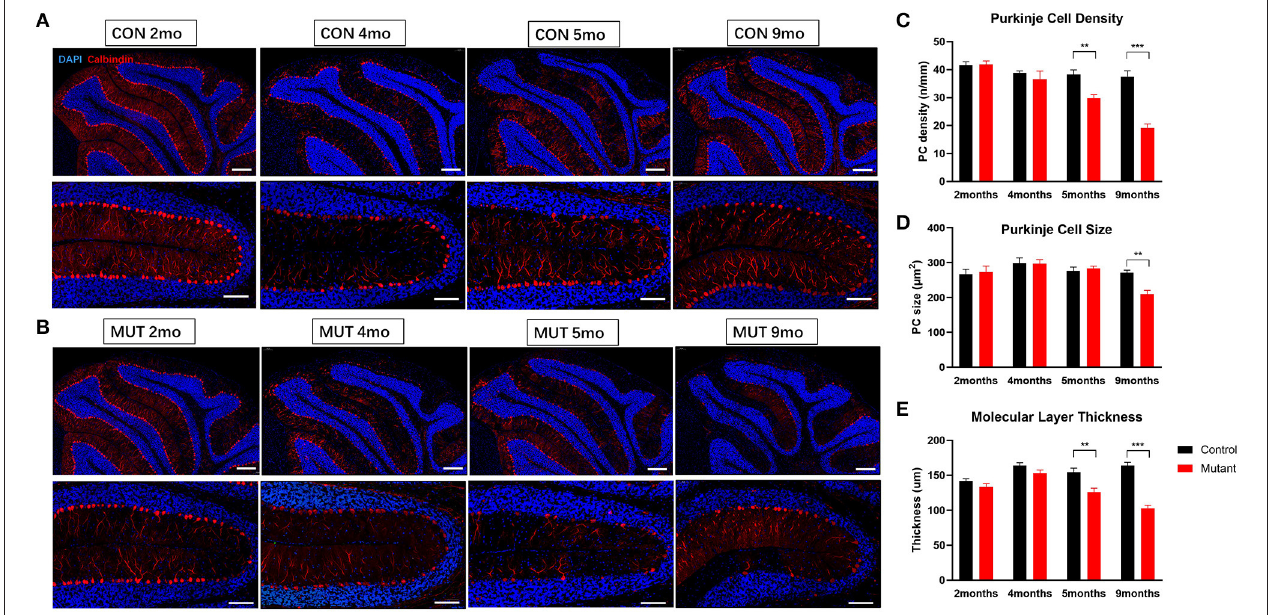
FIGURE 1 | PC Scn8a mutant mice exhibit histological changes in cerebellum. (A,B) Abnormal PC morphology and gradual reduced PC number and molecular layer thickness in Scn8a mutant cerebellum (Scale bar upper row 200 µ m. bottom row 100 µ m). (C,D) The quantification of PC density and the quantification of PC soma area was performed in the IV–V. PC loss was not apparent until 5 months of age, and showed ongoing loss till 9 months (C) . At 9 months, mutant Purkinje cell size decreased significantly (D) . (E) The thickness of the molecular layer (ML) was normal in mutant cerebellum at 4 months of age, whereas it decreased afterward at 5 months ( n ≥ 3 per group. Data shown are means ± SEM. ** P < 0.01, *** P < 0.001, two-way ANOVA, Bonferroni’s post-hoc analysis).